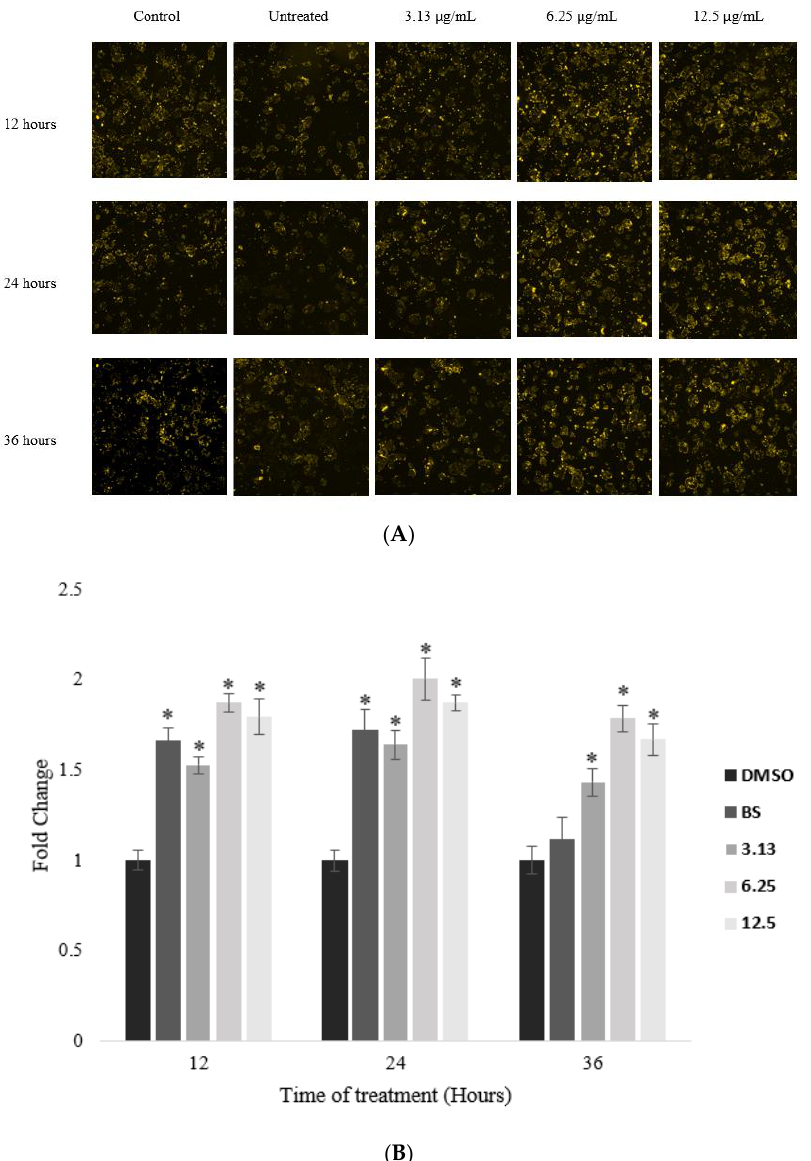
Figure 4. The effects of selected A. planci fraction on the level of LDL-C uptake by the HepG2 cell line at 3 different time points: 12, 24, and 36 h, respectively. Cells were either untreated or treated with 3.13, 6.25, or 12.5 µg/mL of the selected fraction for 12, 24, and 36 h. Images were taken using a high-content screening platform (ImageXpress ® Micro, Molecular Devices) ( A ), and analyzed using ImageJ 1.52a; Java 1.8.0_191 ( B ). Berberine sulfate (BS)-treated cells were used as the positive control. ‘*’ denotes statistically significance ( p < 0.05) as compared to untreated control (DMSO).